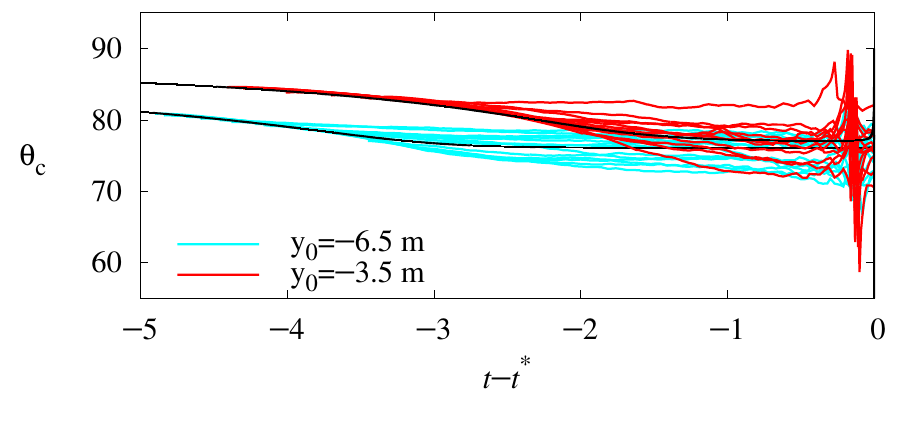
Figure 7. Time evolution of the bearing angle θ c , defined by Equation (6). The gap length is l g = 25m and the initial position is y 0 = − 3.5m and − 6.5m for red and cyan lines, respectively. Colored lines are computed from data, while black lines show the analytical results using average parameter values. The time axis is given in terms of time before crossing t − t ∗ , so that the zero point is equal to the intersection time of the run (i.e., the time at which y ( t ) =